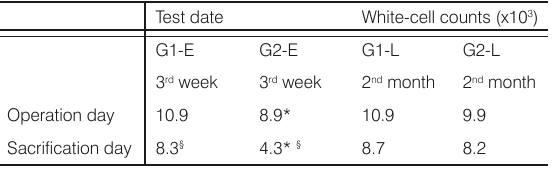
Table 1. The mean values for white-cell counts.